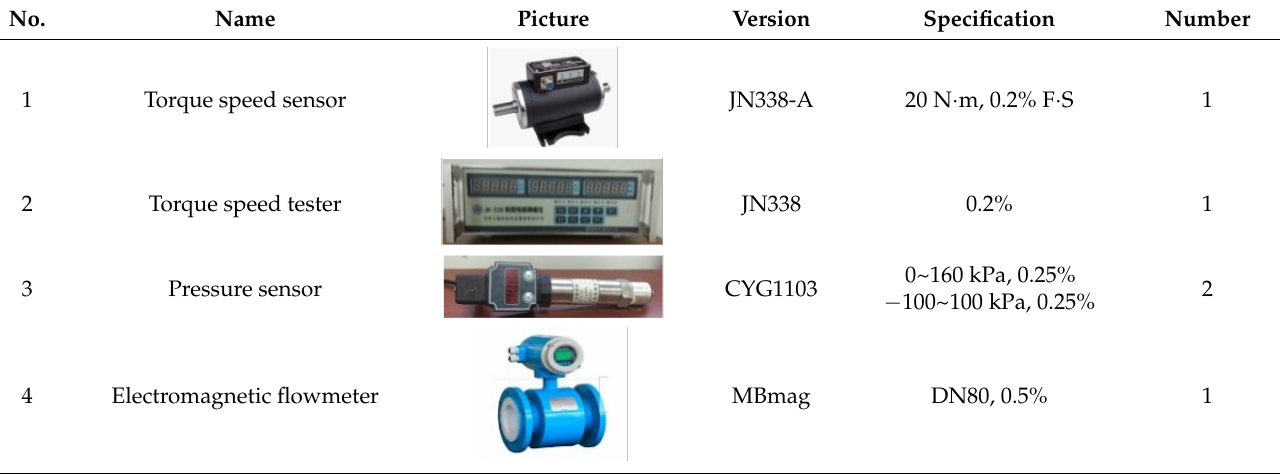
Table 3. Configurations of instrument and